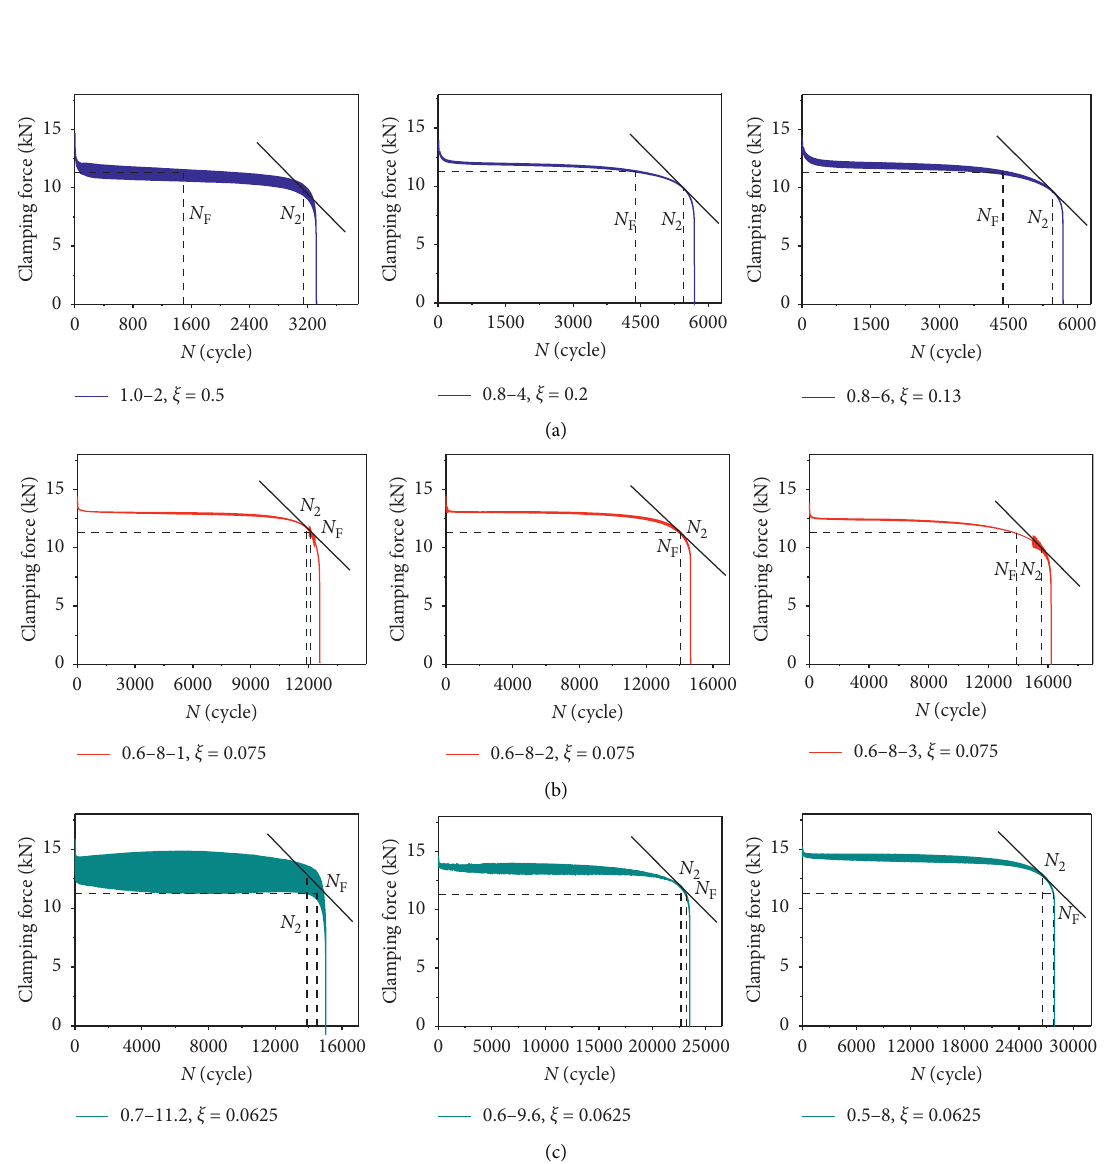
Figure 6: Comparison of clamping force recession curves with different failure modes: (a) loosening failure curves, (b) critical competitive failure curves, and (c) fatigue failure